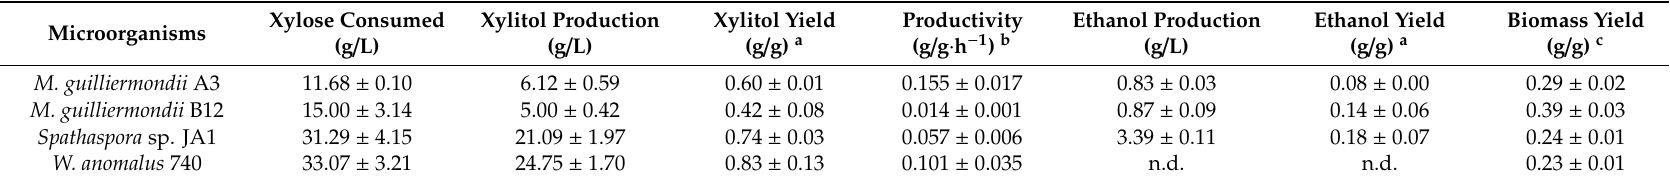
Table 3. Fermentative parameters for the xylitol-producing yeasts M. guilliermondii A3, M. guilliermondii B12, Spathaspora sp. JA1, and W. anomalus 740 in sugarcane bagasse hydrolysate. Values represent average and standard deviation of duplicates values calculated at 44 h of the